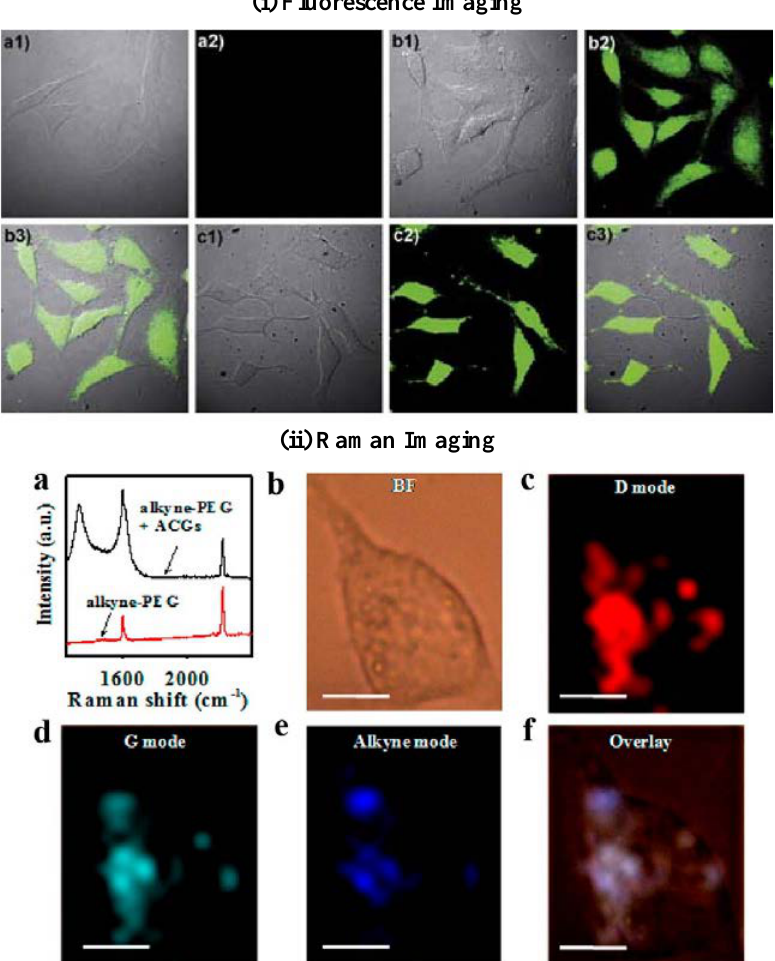
Fig. 6. Graphene-based nanomaterials for bioimaging. (i) Fluorescent imaging. Confocal °uorescence microscopy images of HeLa cells treated with (a) 2.5 (cid:2) g mL (cid:1) 1 PEG – G and Fluo – G suspension for 6h at (b) 37 (cid:5) C and (c) 4 (cid:5) C. Bright-¯eld images are marked 1 , dark-¯eld images are marked 2 , and overlap of images of dark and bright ¯eld are marked 3 . Reproduced with permission from Ref. 122. Copyright 2010 Wiley- VCH Verlag GmbH & Co. KGaA, Weinheim. (ii) Raman imaging. Cell imaging with alkyne-PEG-func- tionalized ACGs. (a) Raman spectra of alkyne-PEG with (black) and without (red) ACGs. (b) – (f) Raman image of MCF-7 cells treated with alkyne-PEG-modi¯ed ACGs using 1s integration/pixel. BF, bright ¯eld; scale bar, 10 (cid:2) m. Reproduced with permission from Ref. 132. Copyright 2014 American Chemical Society. (iii) Magnetic Resonance imaging. (a) HeLa cells ( 2 (cid:6) 105 cells mL (cid:1) 1 ) incubated with the Fe 3 O 4 - GO composites at di®erent concentrations for 24h. (b) Fe3O4-GO composites (20 (cid:2) g Fe mL (cid:1) 1 ) incubated with HeLa cells at di®erent cell densities for 24h. Reproduced with permission from Ref. 134. Copyright 2011 American Chemical Society. (iv) Radiolabeled imaging. Serial coronal PET images of 4T1 tumor- bearing mice at di®erent time points postinjection of 64 Cu-NOTA-GO-TRC105, 64Cu-NOTA-GO, or 64 Cu-NOTA-GO-TRC105 after a preinjected blocking dose of TRC105. Tumors are indicated by arrow- heads. Reproduced with permission from Ref. 136. Copyright 2012 American Chemical